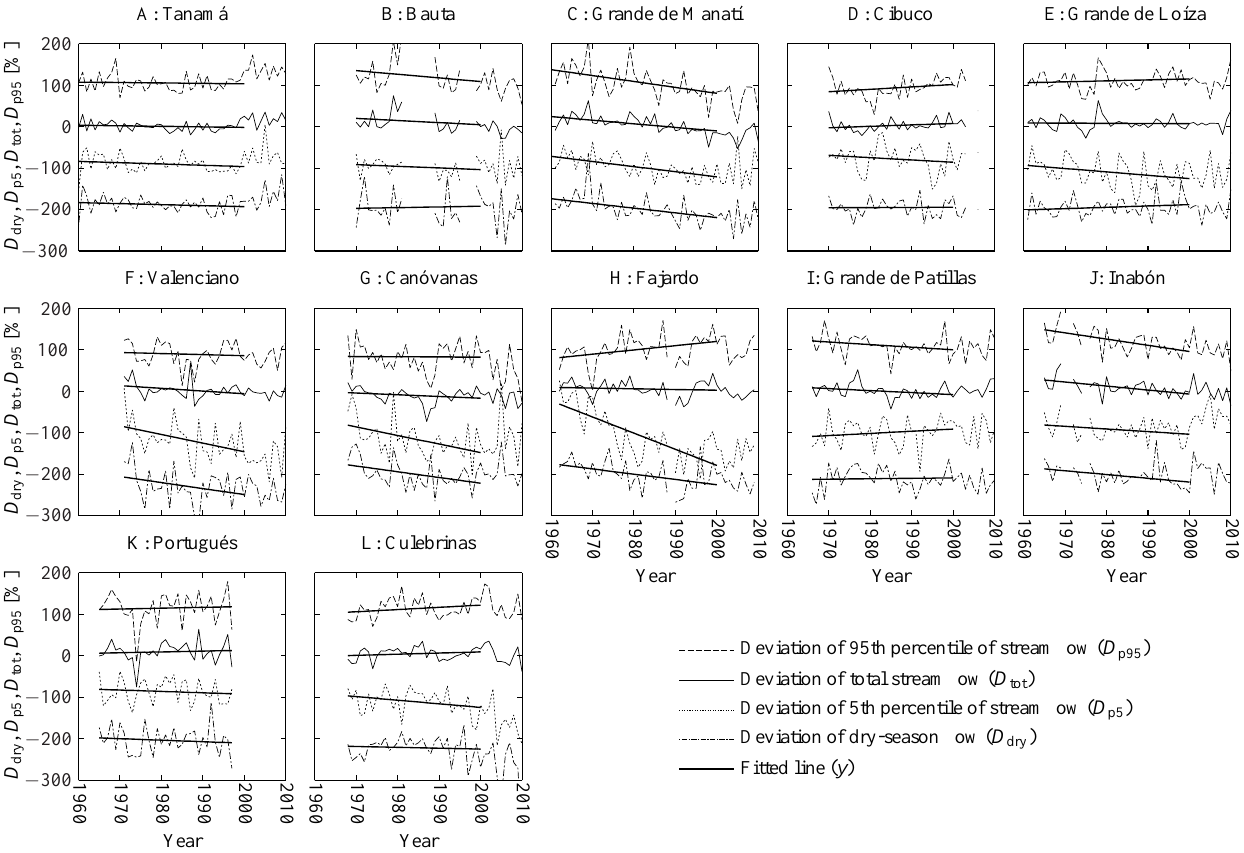
Fig. 6. Annual time series of D p95 , D tot , D p5 , and D dry (displayed, respectively, from top to bottom in each panel; calculated using Eq. 4) and fitted trend lines. For clarity the D p95 , D p5 , and D dry time series were offset by + 100, − 100, and − 200%,